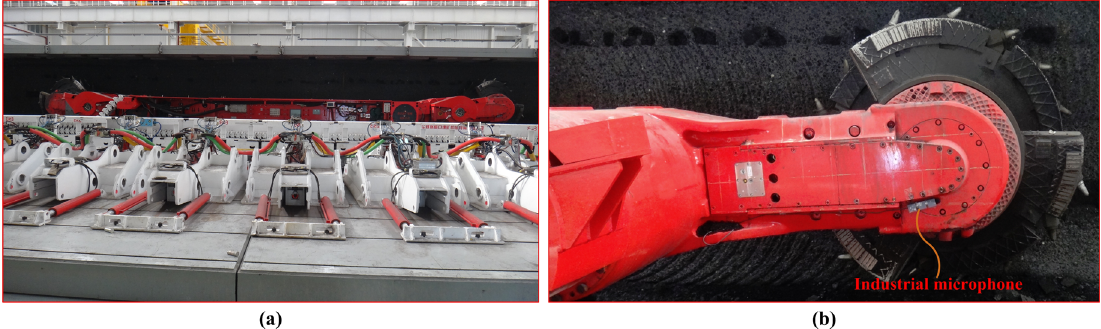
Figure 4. The experimental site. ( a ) Site layout of the platform; and ( b ) installation of the microphone.